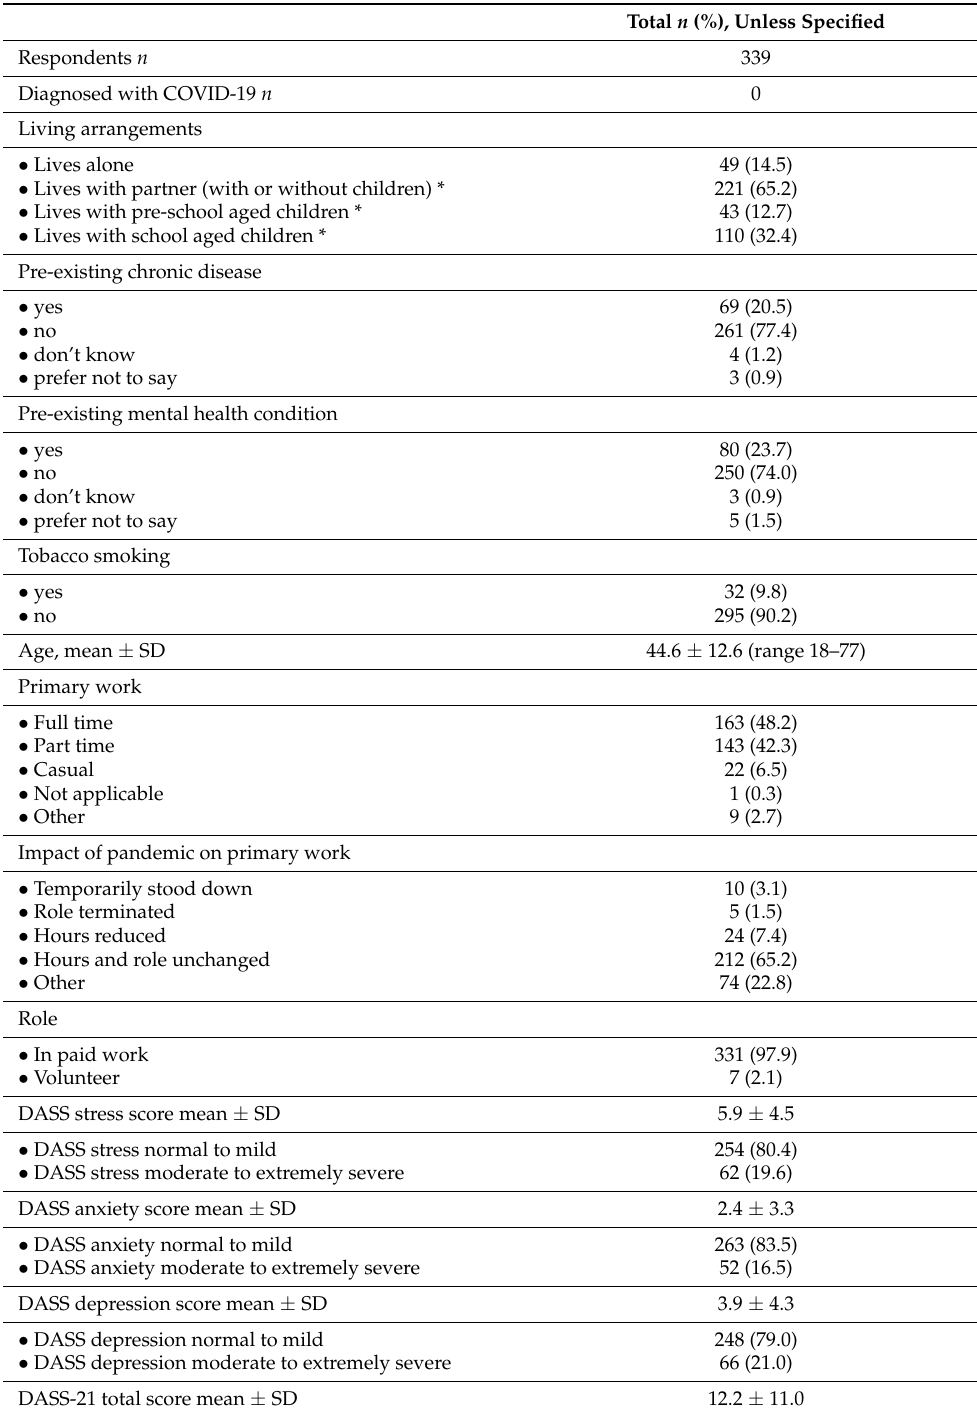
Table 1. Demographic characteristics and DASS-21 scores of female respondents residing in rural